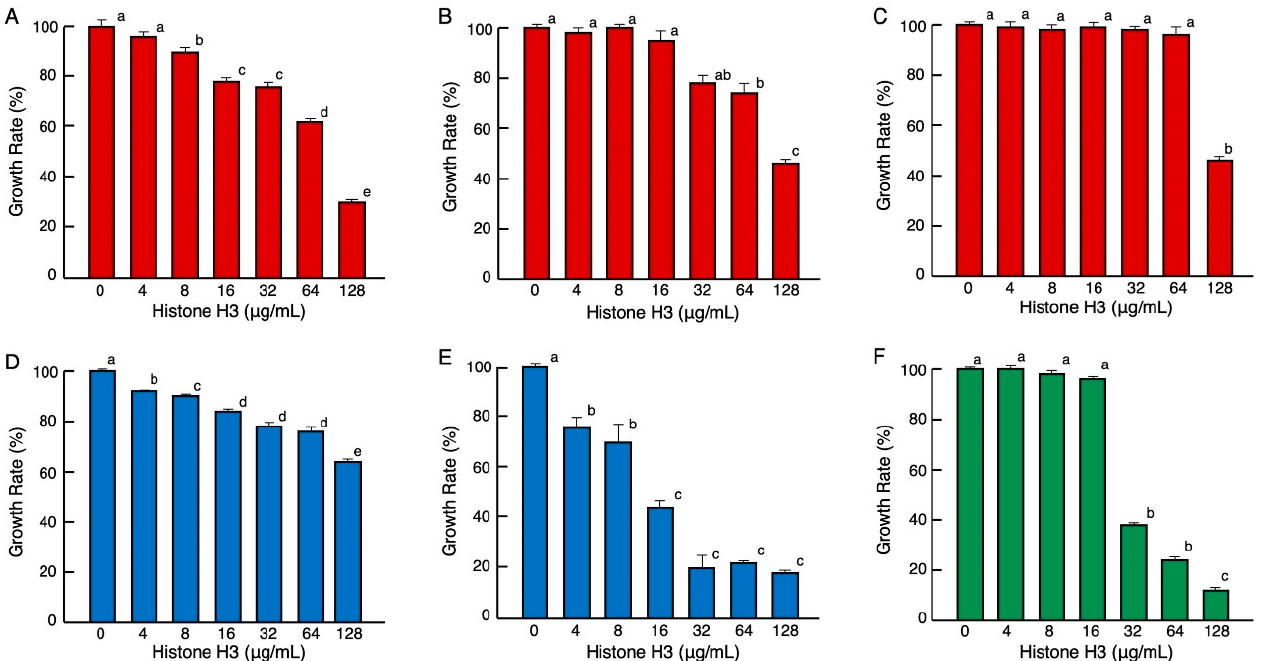
Figure 1. Effects of various concentrations of histone H3 on the growth of pathogenic Gram-negative bacteria (red columns) E. aerogenes ( A ), S. enterica ( B ), P. aeruginosa ( C ), Gram-positive bacteria (blue columns) B. cereus ( D ) , S. mutans ( E ), and fungus (green columns) C. albicans ( F ). Cells of each microbial strain were incubated with two-fold serially diluted calf thymus histone H3 for 18 h ( A – D ), 36 h ( E ), or 24 h ( F ) at 37 ◦ C. Each column and vertical line represent the mean and standard error of the mean, respectively ( n = 4). The growth rates are expressed relative to the control (0 µ g/mL histone H3). In all panels, values with the same letters (a–e) are not significantly different ( p ≥ 0.05).